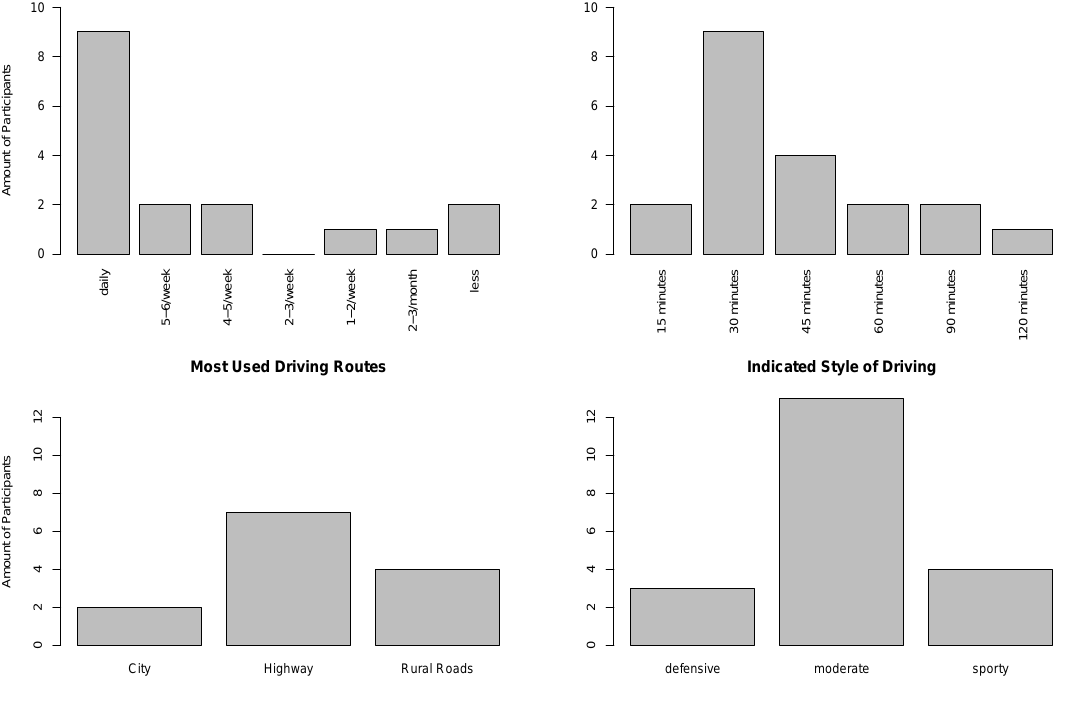
Figure 2. Distributions of driving statistics of the participants ( N =